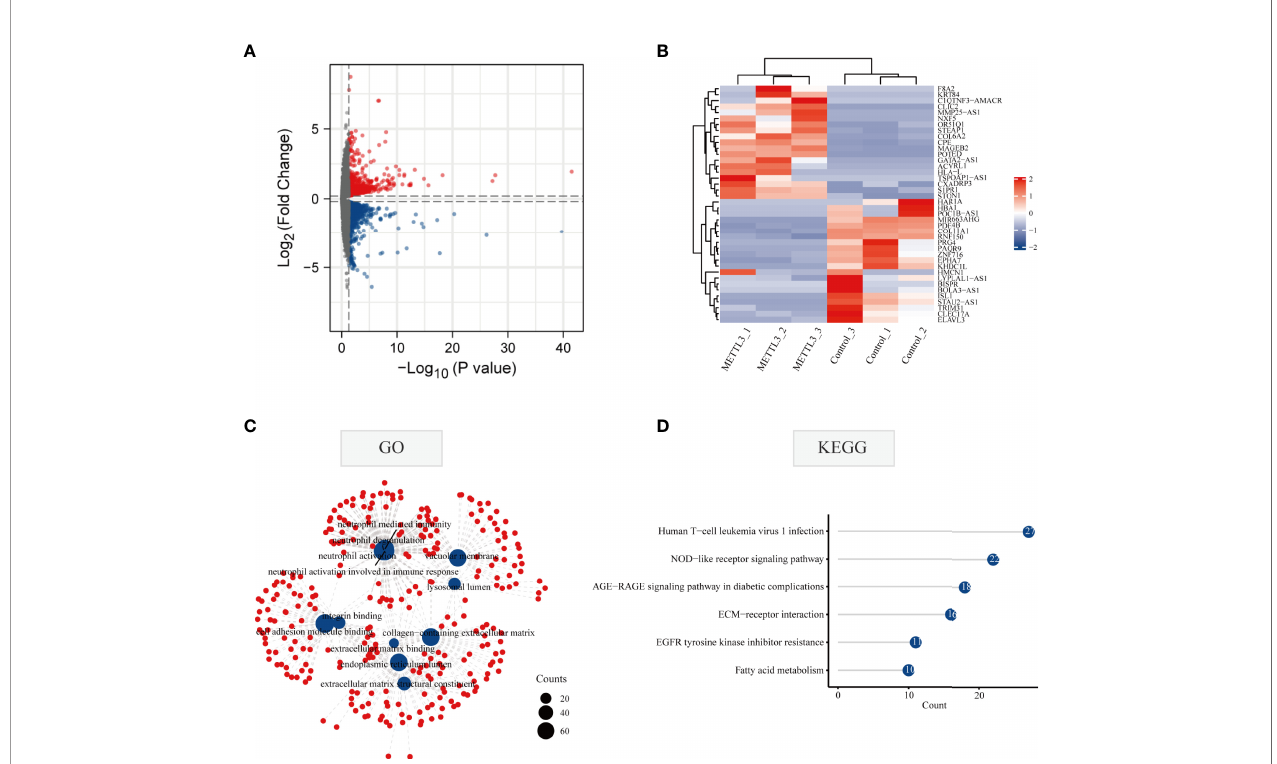
FIGURE 3 | Gene alterations at the transcriptional level regulated by METTL3 overexpression. (A) Volcano diagram of differentially expressed genes regulated by METTL3. The red and blue dots in the plot represent upregulated and downregulated genes, respectively. Black spots represent genes changed with no signi fi cance. (B) The top 20 genes with the highest or lowest change of expression regulated by METTL3 were shown in the heatmap. (C) GO enrichment analysis of METTL3-regulated differentially expressed genes at the transcriptional level; (D) KEGG enrichment analysis of METTL3-regulated differentially expressed genes at the transcriptional